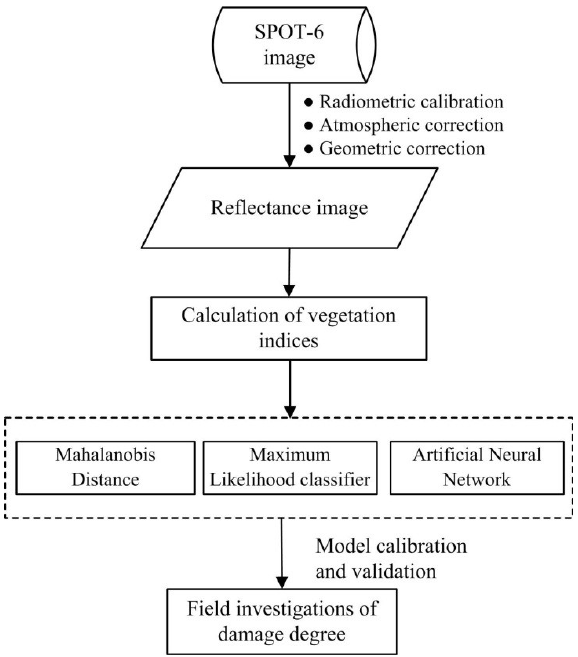
Figure 3. Flowchart of data analysis and